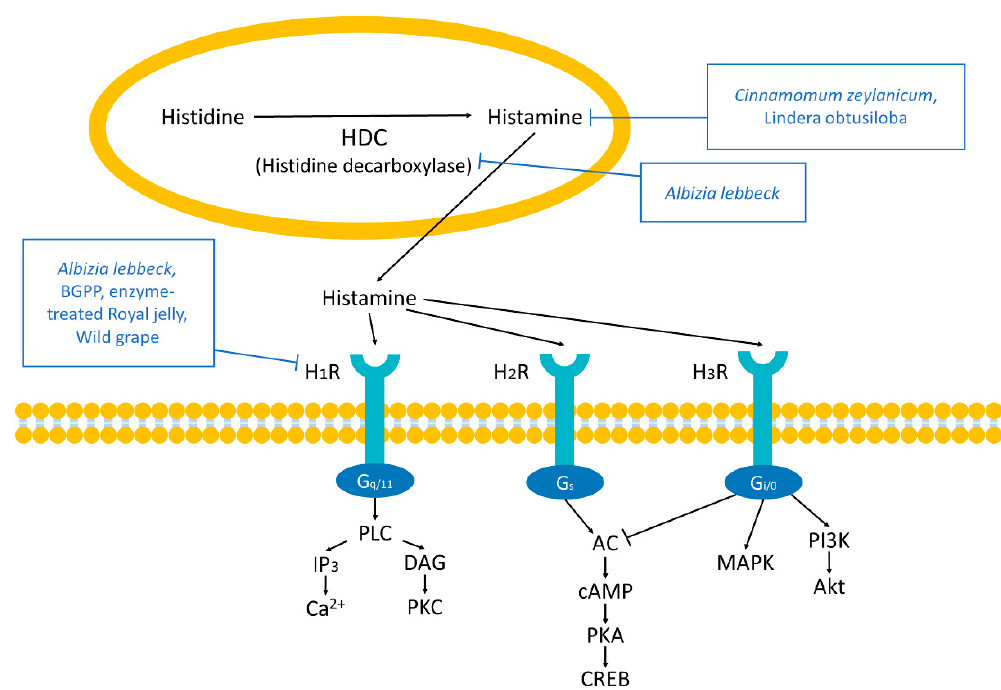
Figure 3. Histamine receptors. HDC, histidine decarboxylase; H1R, histamine H1 receptor; H 2 R, histamine H2 receptor; H 3 R, histamine H3 receptor; G, G protein; IP 3 , inositol 3,4,5-triphosphate; DAG, diacylglycerol; PKC, protein kinase C; AC, adenylyl cyclase; cAMP, cycling AMP; PKA, protein kinase A; CREB, cAMP-responsive element binding protein; MAPK, mitogen-activated protein kinase; Pl3K, phosphatidylinositol 3-kinase; Akt, protein kinase B; BGPP, Brazilian green propolis.